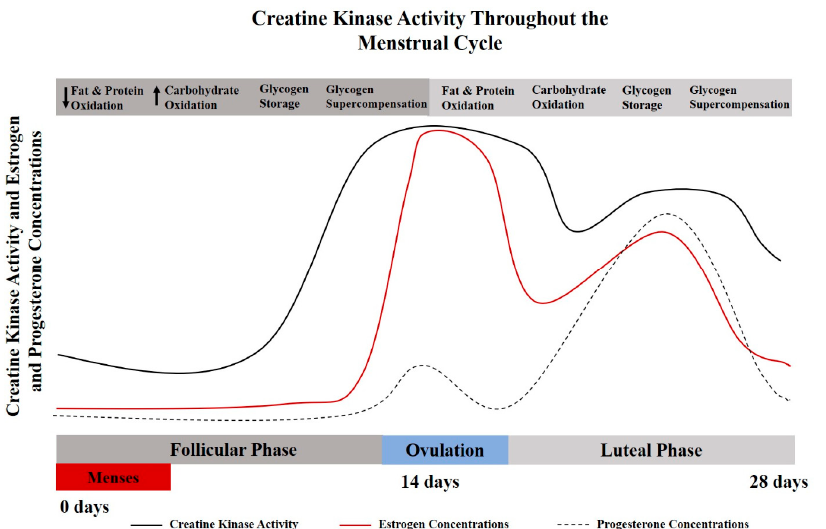
Figure 1. A theoretical model for the interplay between creatine kinase and menstrual cycle hor- mones [6,10,11]. Creatine metabolism and creatine kinase concentrations vary throughout the men- strual cycle and lifecycle. These alterations may also influence metabolic characteristics of protein and carbohydrate oxidation [12], which provides a physiological basis for the potential use of creatine supplementation for